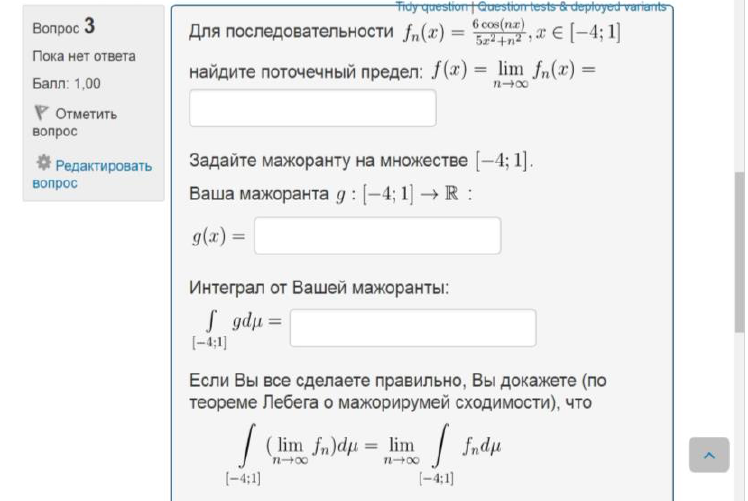
Fig. 6. STACK interactive task on applying the Lebesgue Theorem (TSU) / question, attempts left, score, mark the question, edit question / for the sequence find the point limit. Set the majorant on the sequence. Your majorant. If you are doing it correctly, you will prove (according to the Lebesgue Theorem of dominated convergence)